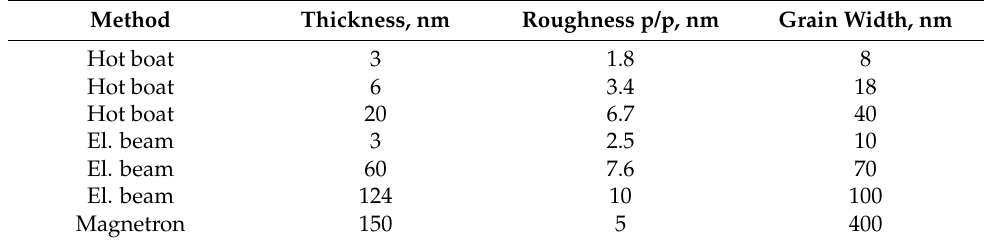
Figure 3. ( a ) Al NIS junction with 150 nm-thick aluminum electrode fabricated by magnetron sputtering; ( b ) IV curves and dynamic resistance for this NIS junction. Peak-to-peak roughness in the region out of peaks is 5 nm, and grain size is 400 nm. Table 1. Film thickness and surface